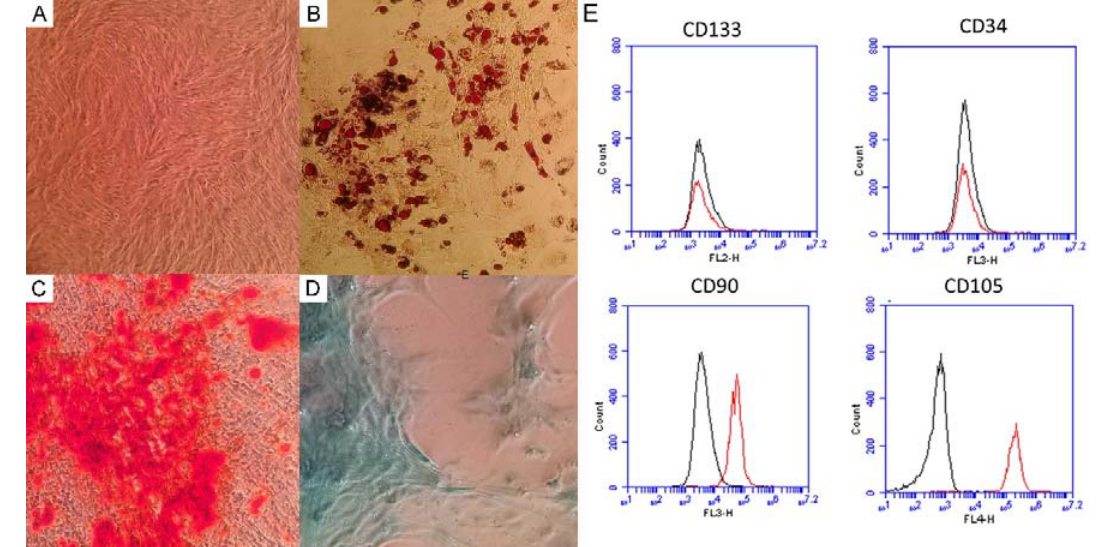
Figure 1. Morphology, characterization and differentiation potential of adipose-derived stromal cells–( A ) Undifferentiated culture demonstrating cells with fibroblast characteristics, ( B ) adipogenic differentiation culture and lipid vacuoles stained with Oil Red O, ( C ) osteogenic differentiation culture and calcium deposits stained with Alizarin Red and ( D ) chondrogenicdifferentiation culture and glycosaminoglycan-rich extracellular matrix stained with Alcian Blue. ( E ) Immunophenotypic profile of mesenchymal stromal cells. Cells expressed the CD 90 and CD105 markers and did not express CD133 and CD34.